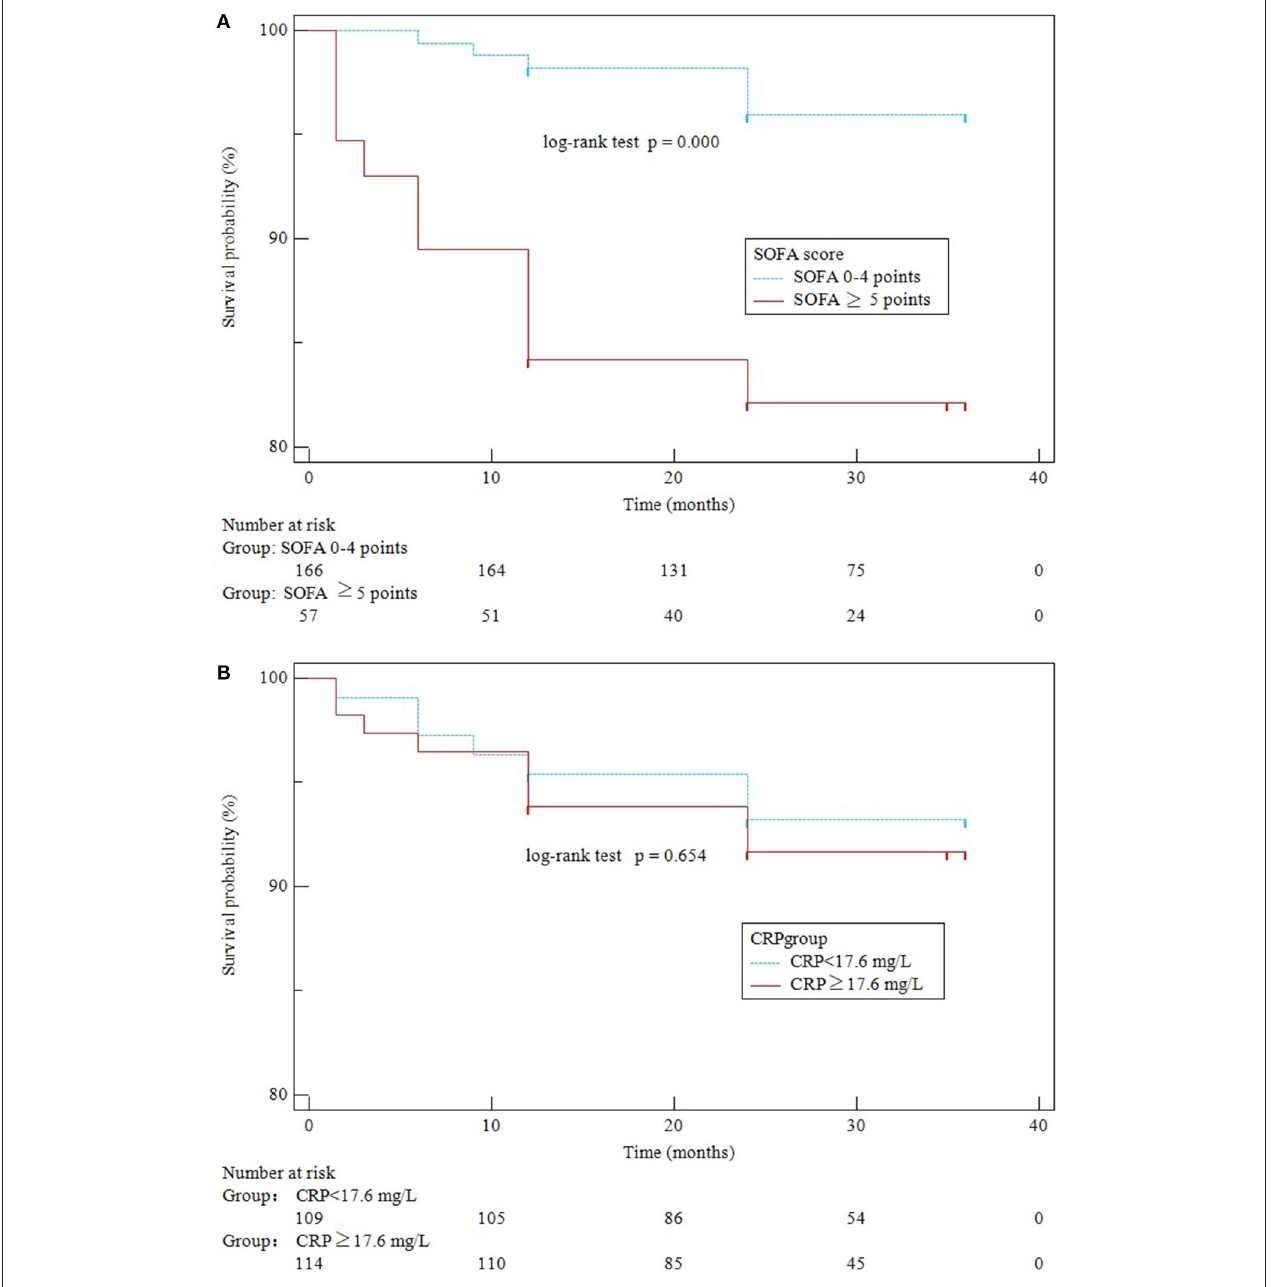
FIGURE 3 | Kaplan–Meier curves of SOFA scores (A) and CRP levels (B) for survival over 3 years of follow-up.